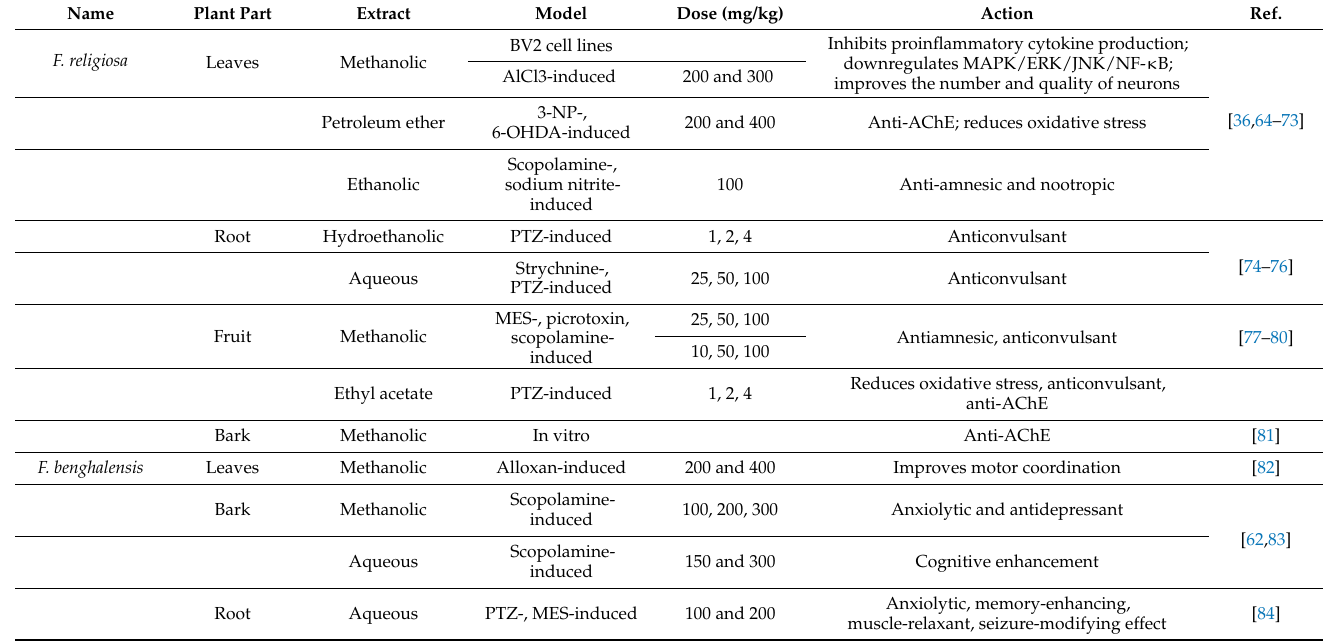
Table 1. Neuroprotective mechanism of Ficus